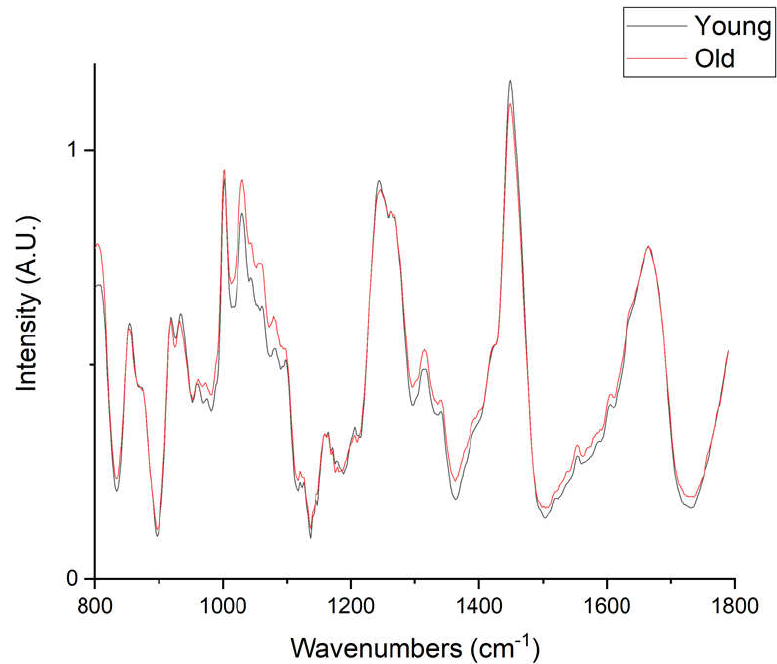
Figure 4. Averaged pooled Raman spectra of young (70 spectra) and old (80 spectra) tendons.